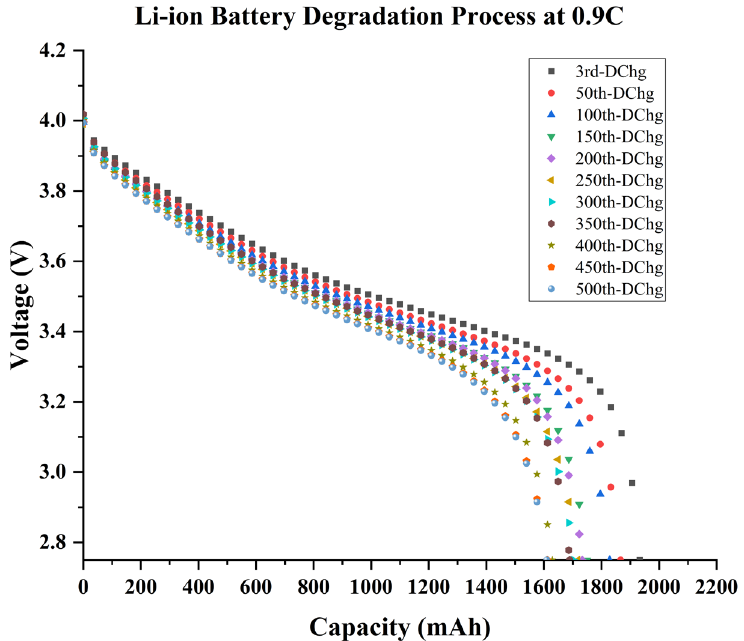
Figure 5. The battery degradation process at 0.9 C-rate for 500 cycles, where degradation is shown every 50 cycles.